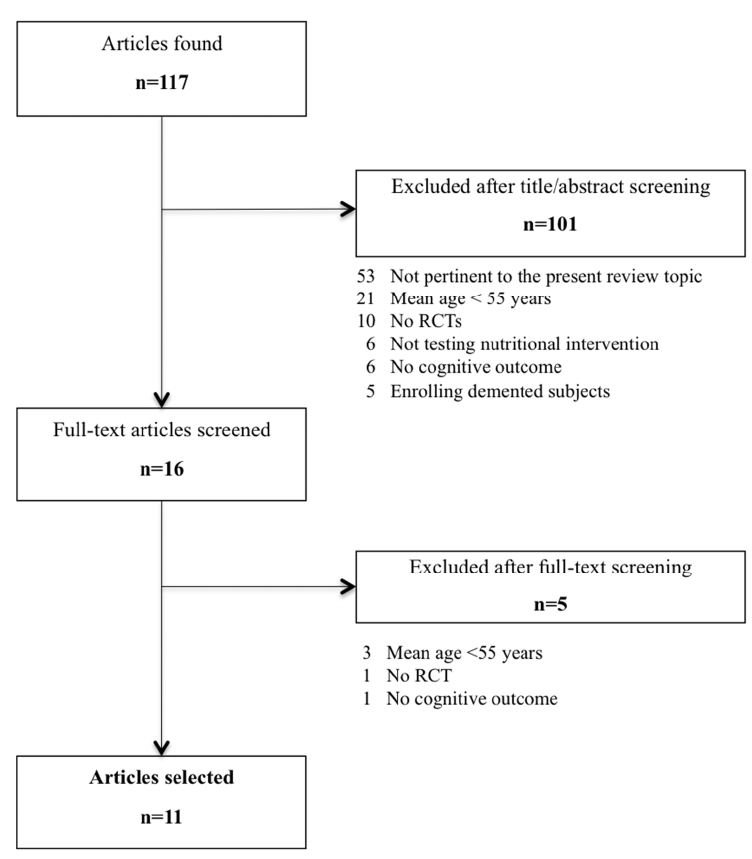
Figure 1. Flow ‐ chart of articles selection. Figure 1. Flow-chart of articles